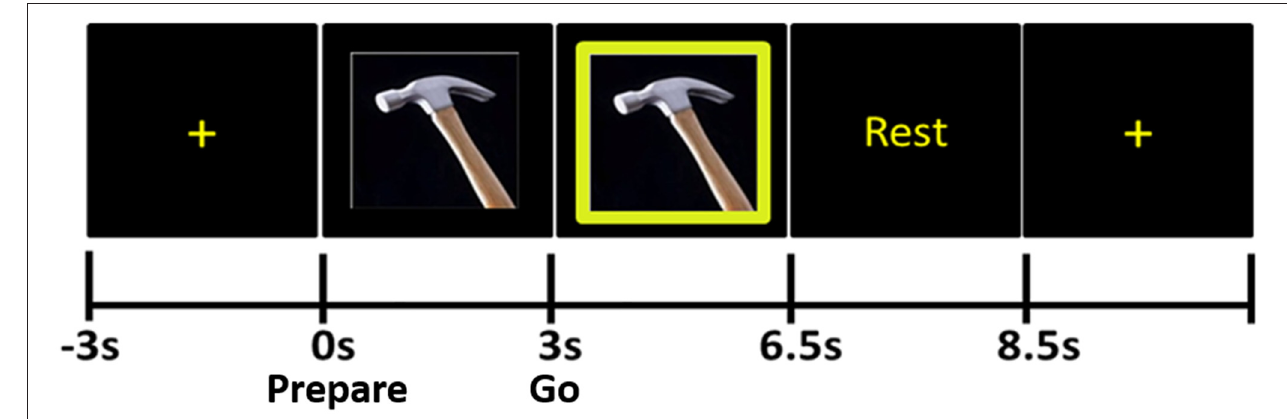
FIGURE 1 | Praxis task. The tool photograph that appears immediately after the fixation cross is the Prepare stimulus, during the presentation of which subjects do not move. When the green frame appears around the photograph ( Go stimulus), subjects pantomime the use of the tool.